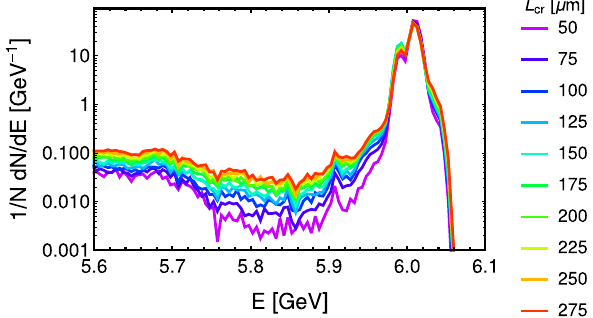
Fig. 14 Energy distributions of the beam, deflected by a bent crystal at the position of the septum magnet for different crystal thicknesses and Si crystals bent along the (111) planes with a deflection angle of 1.75 mrad after 100 revolutions in the